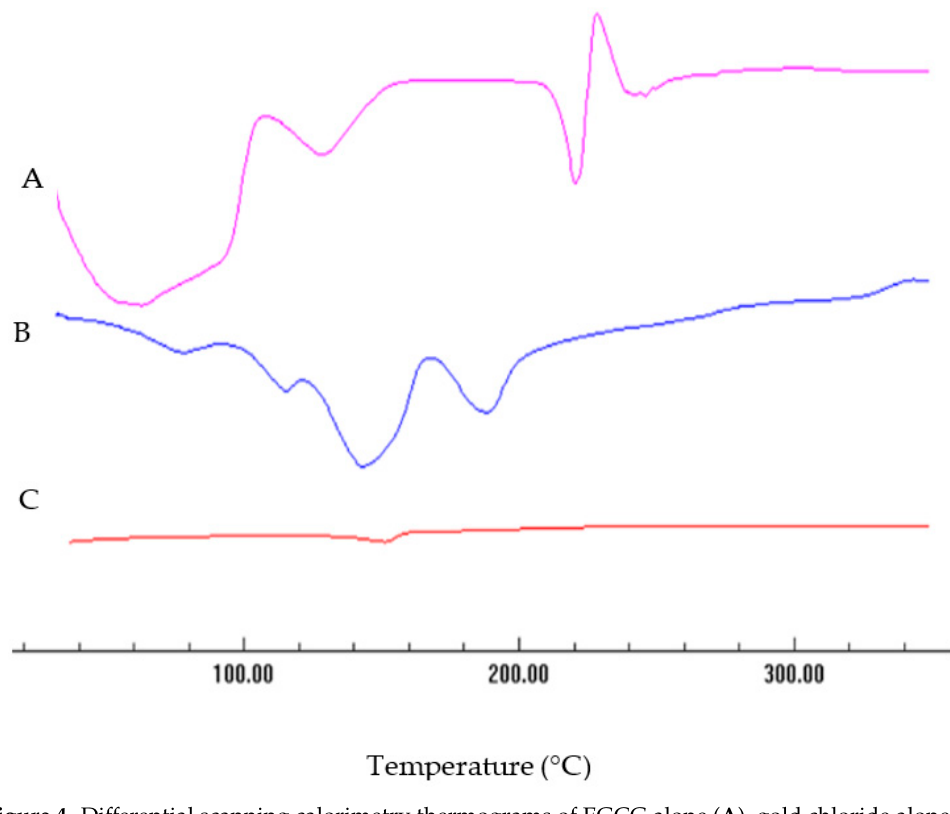
Figure 4. Differential scanning calorimetry thermograms of EGCG alone ( A ), gold chloride alone ( B ) and EGCG-GNPs (formulation F2) ( C ). Disappearance of drug melting endotherm in EGCG-GNPs trace is probably due to drug transformation to an amorphous state.